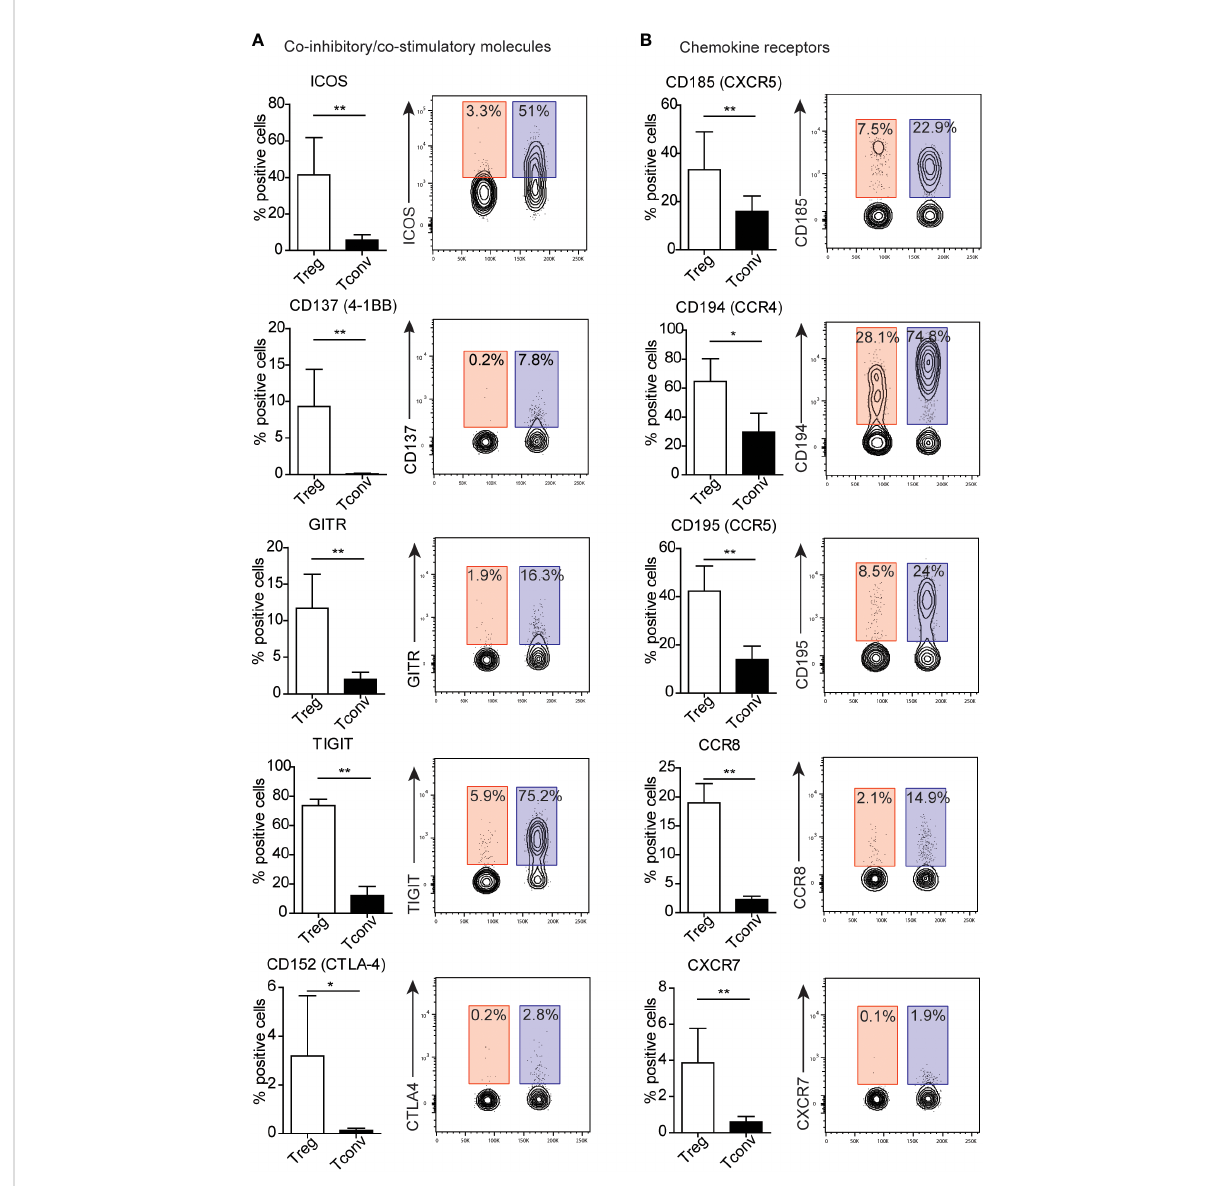
FIGURE 3 Treg cells exhibit distinct patterns of expression of co-inhibitory and co-stimulatory molecules and chemokine receptors. (A) Co-inhibitory and co-stimulatory molecules and (B) chemokine receptors, Numbers adjacent to gates on contour plots indicate the percent gated cells as positive for the given surface marker (blue – Treg, red – Tconv cells). To compare Treg and Tconv cells, plots were made by the concatenation function by FlowJo. Data are presented as bars (n=5, for both Treg and Tconv). All data represent the mean ± SD. *P ≤ 0.05 and **P ≤ 0.01 (Mann Whitney test (A, B)